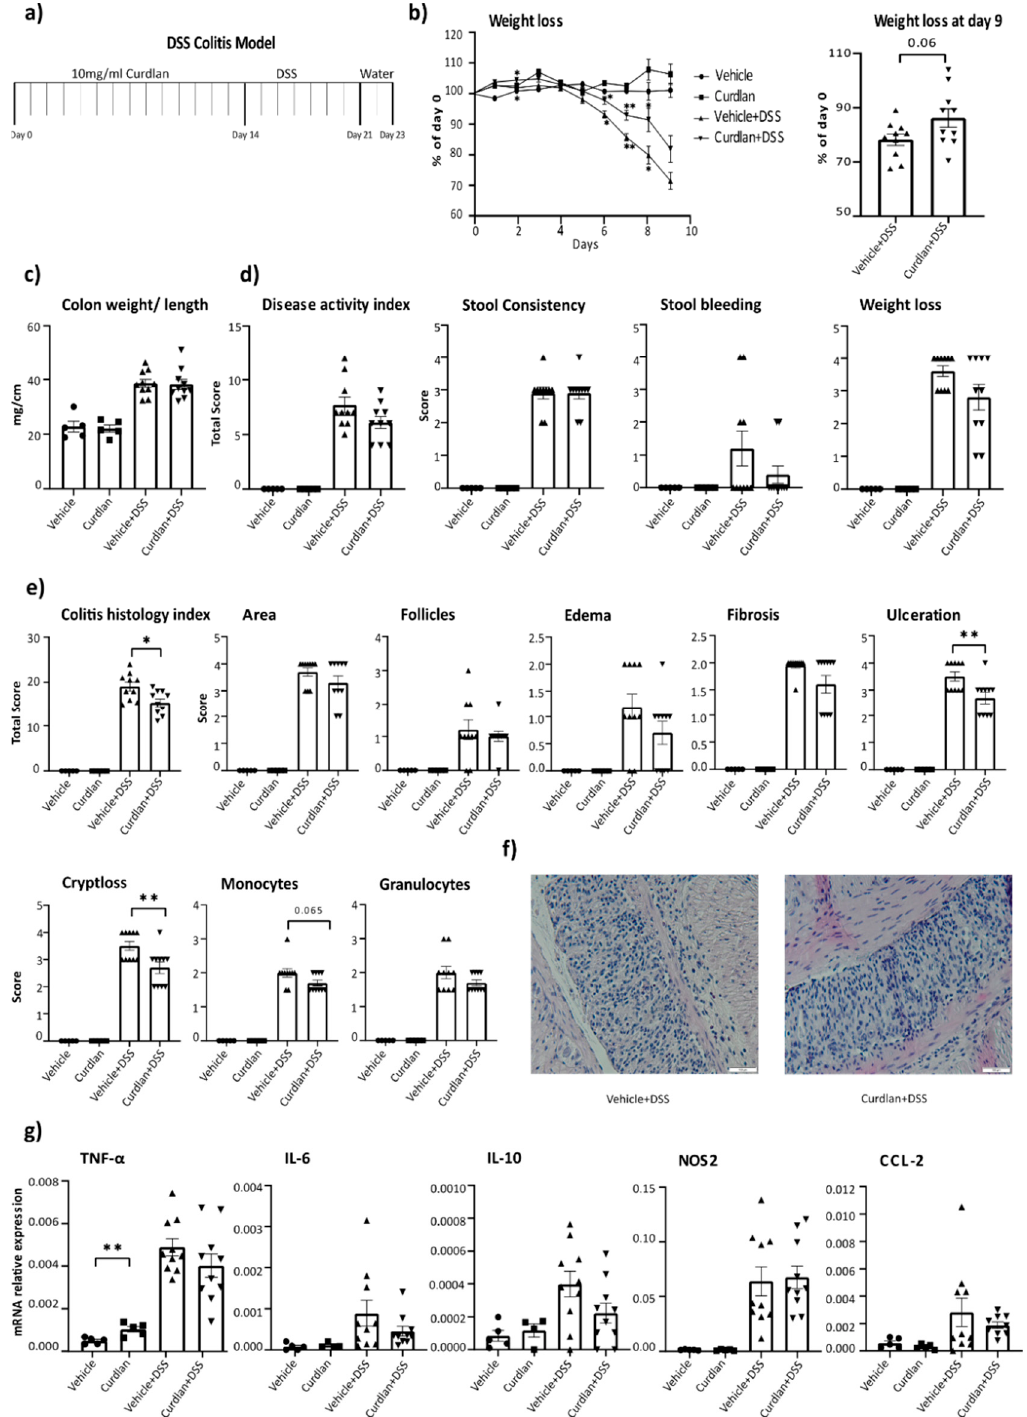
Figure 1. Effects of curdlan intake on dextran sodium sulfate (DSS) colitis in mice. ( a ) A schematic presentation of curdlan feeding in mice. ( b ) bodyweight changes of mice with and without DSS colitis, compared to day 0. ( c ) Colon weight normalized to length as an indication of inflammation. ( d ) Disease activity index according to [32]. ( e ) Mouse colitis histology index according to Table 1 [33]. ( f ) Representative picture of colon histology of vehicle- and curdlan-fed mice with DSS-induced intestinal inflammation, 10× magnification. ( g ) mRNA expression of TNF- α , IL-6, IL-10, NOS2 and CCL-2 in colon homogenates. The levels of mRNA were normalized for reference genes. Samples with no amplification were considered as 0. N = 4–5 for controls and 9–10 for DSS-subjected mice. Individual values are expressed as mean and standard error of mean. Statistical differences were tested by independent t-test, where a p -value of < 0.05 was considered to be significant. * p -value < 0.05; ** p -value < 0.01.